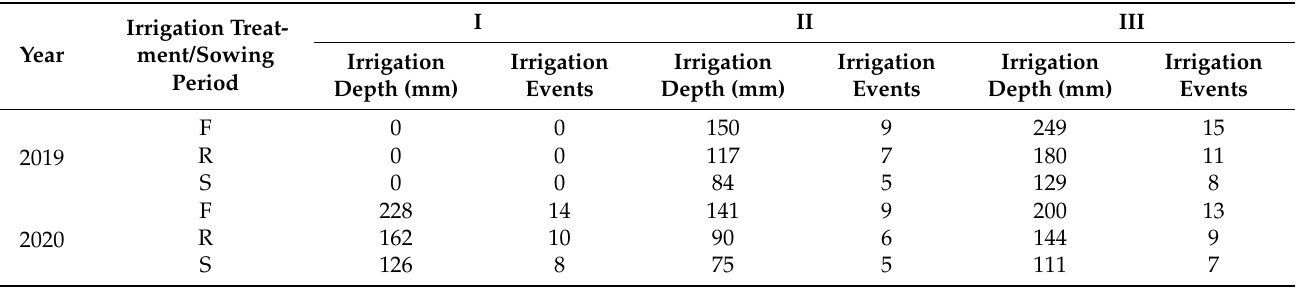
Table 1. Irrigation treatments of common